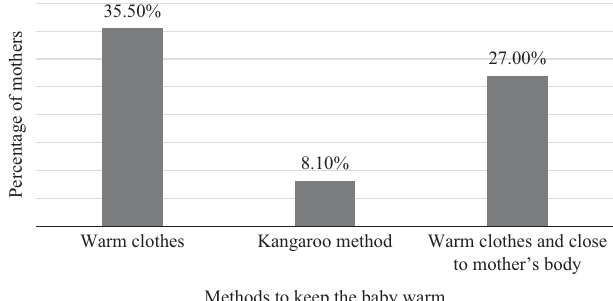
Figure 1. Knowledge about the methods to keep the baby warm